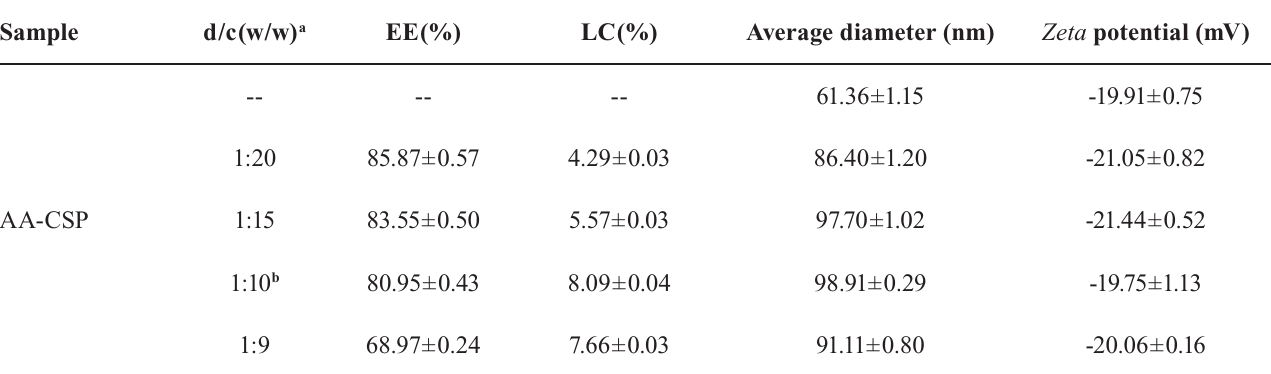
TABLE II - The characterization of DTX-AA-CSP nanoparticles